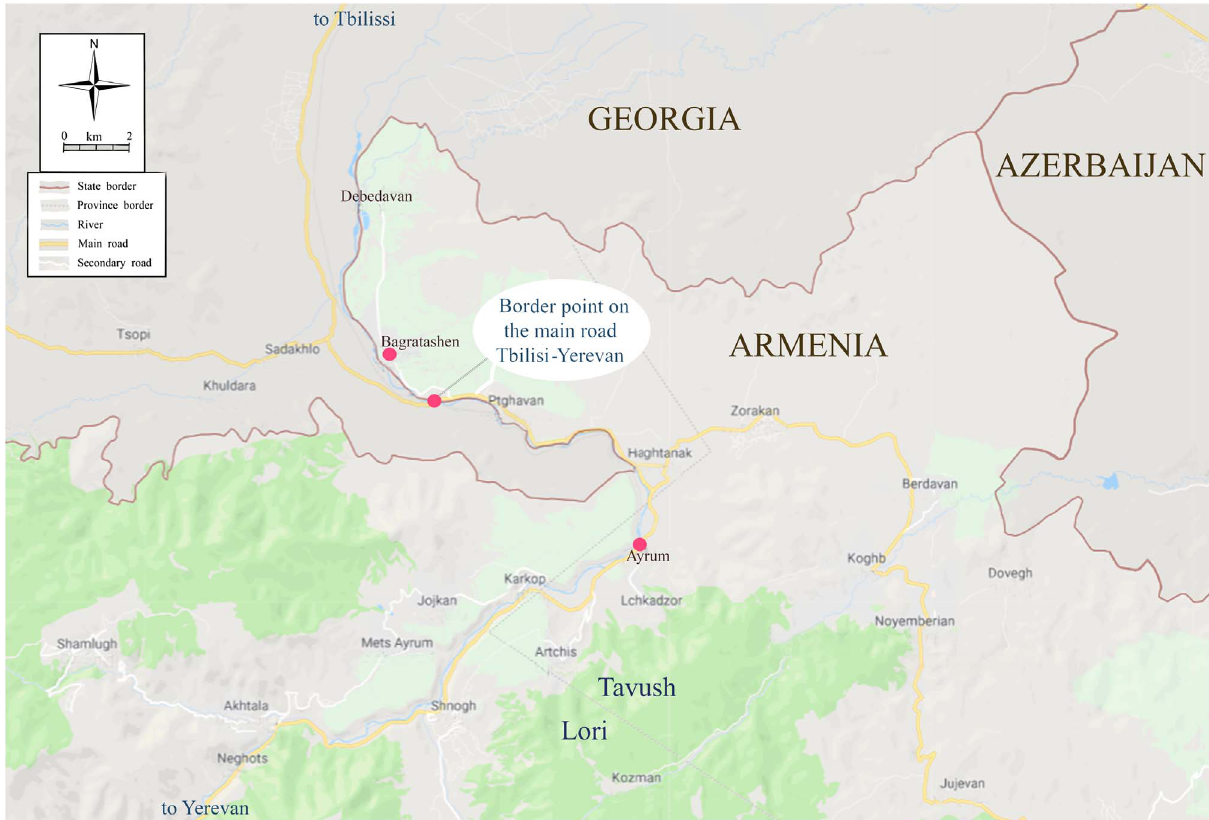
Figure 3. Location of the sites where Aedes albopictus was recorded in 2016 – 2018, north